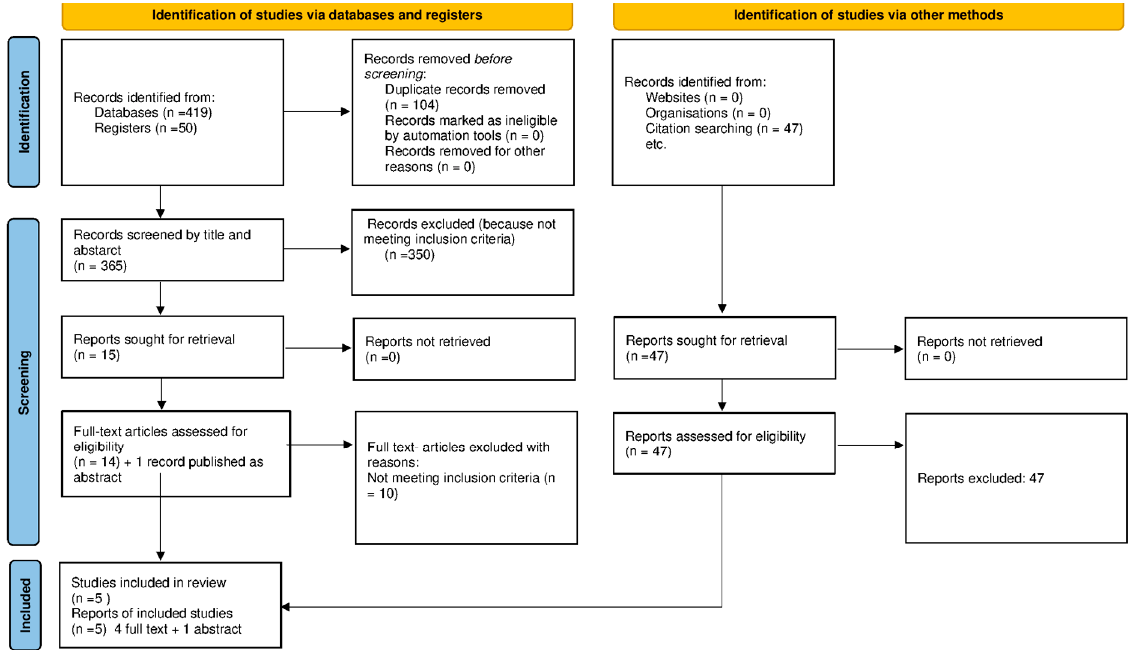
Figure 1. PRISMA 2020 flow diagram for new systematic reviews that includes searches of databases, registers, and other sources.